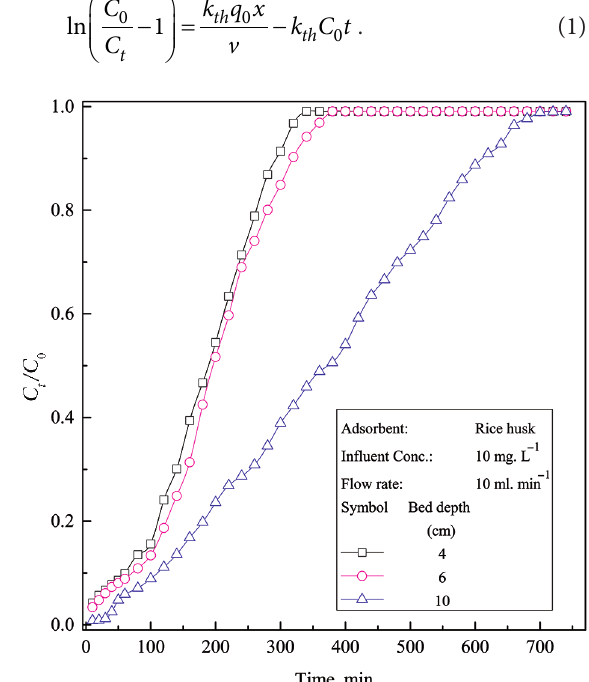
Figure 3. Effect of pH